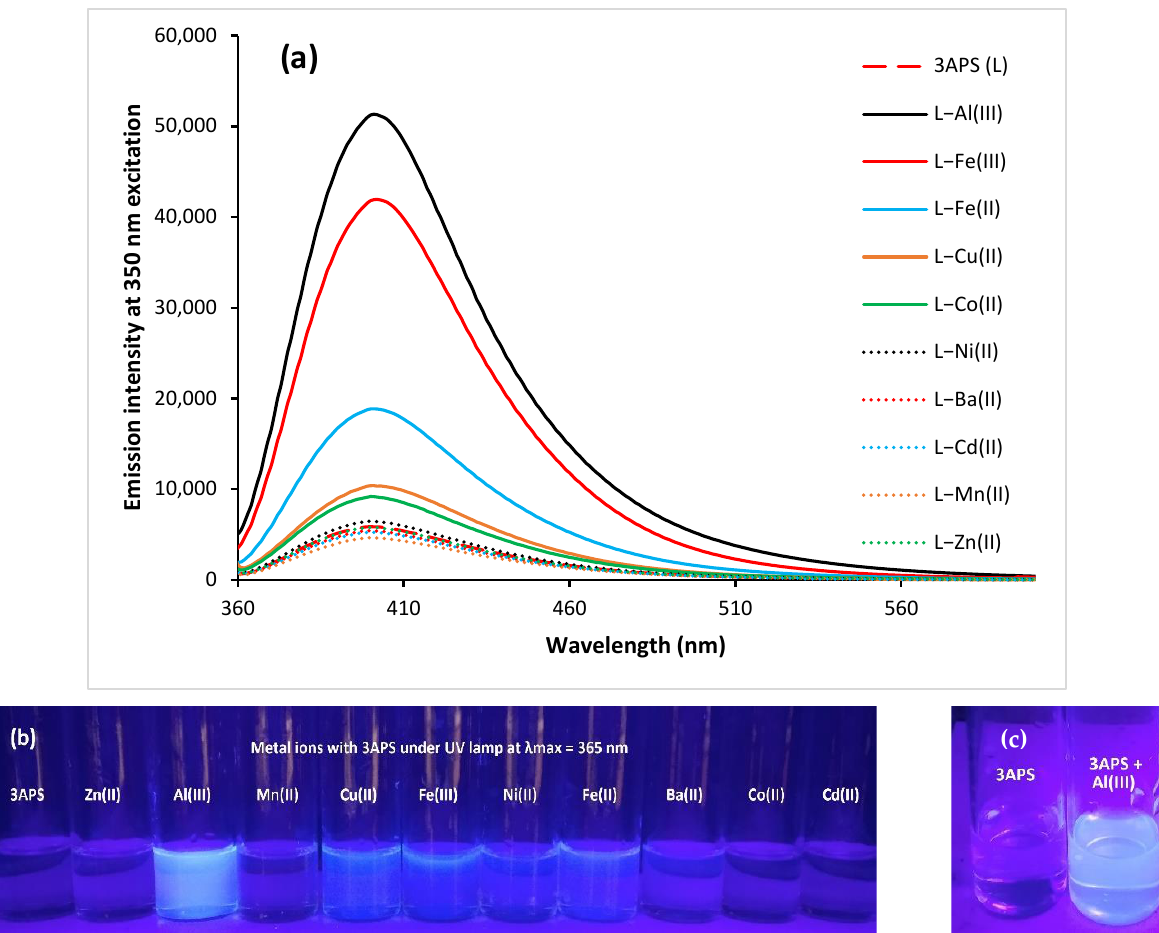
Figure 7. Fluorescence intensity of 3APS (2 × 10 − 6 M) upon complexation with various metal solutions (1 × 10 − 4 M each) in ACN–water (1:9) ( a ). Photo of 3APS upon the addition of metal ions under UV lamp at 365 nm ( b ) and photo of 3APS before and after adding 10 equivalents of Al(III) under UV lamp at 365 nm ( c ).